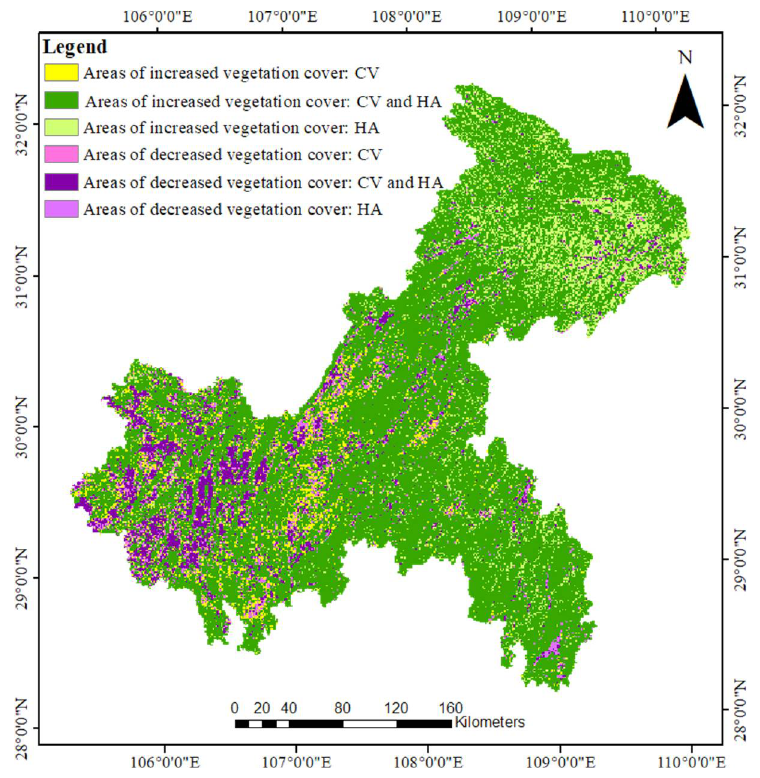
Figure 8. Spatial distribution of drivers of vegetation-cover change in Chongqing from 2000–2020. CV denotes climate variations and HA denotes variations due to human activities. Table 5. Area and proportion of vegetation-cover changes influenced by different drivers.